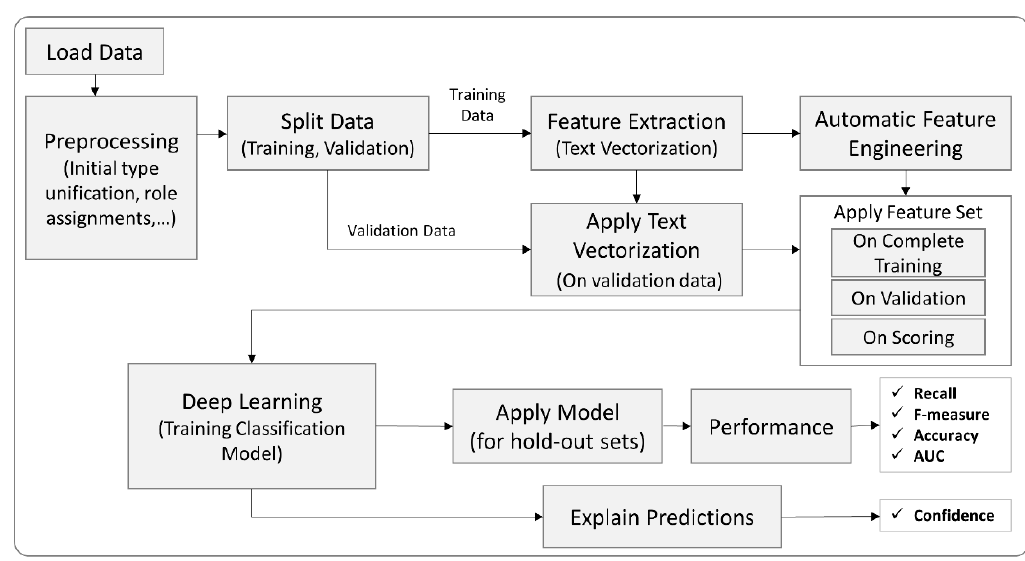
Figure 2. Abstract description of the proposed deep learning process model .